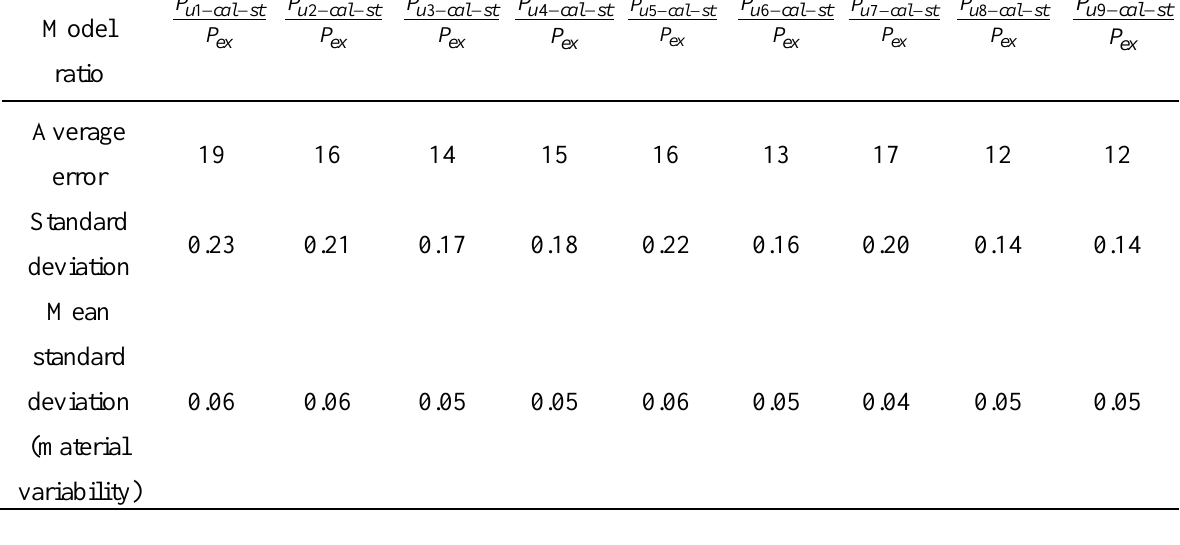
Table 6. Summary of stochastic results for the calibrated models.